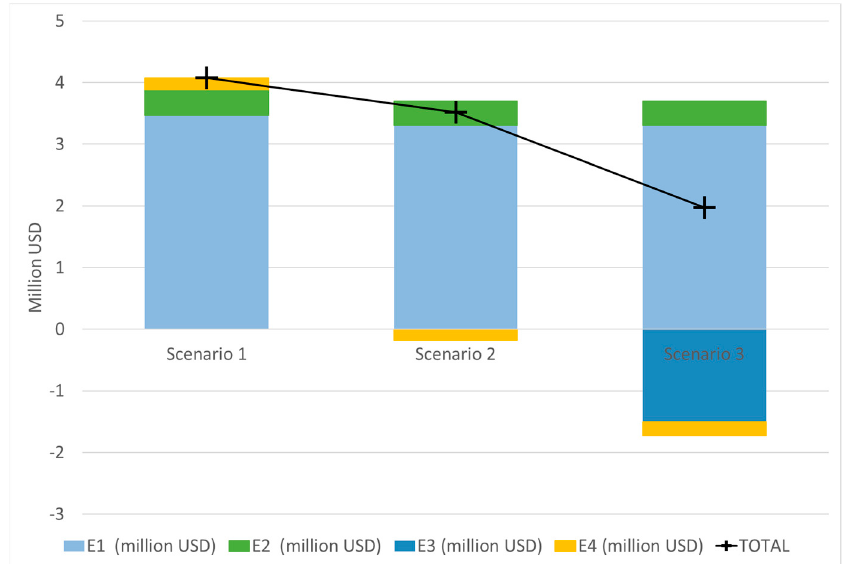
Figure 4. Distribution of costs according to the scenario, taking into account the application of pen-